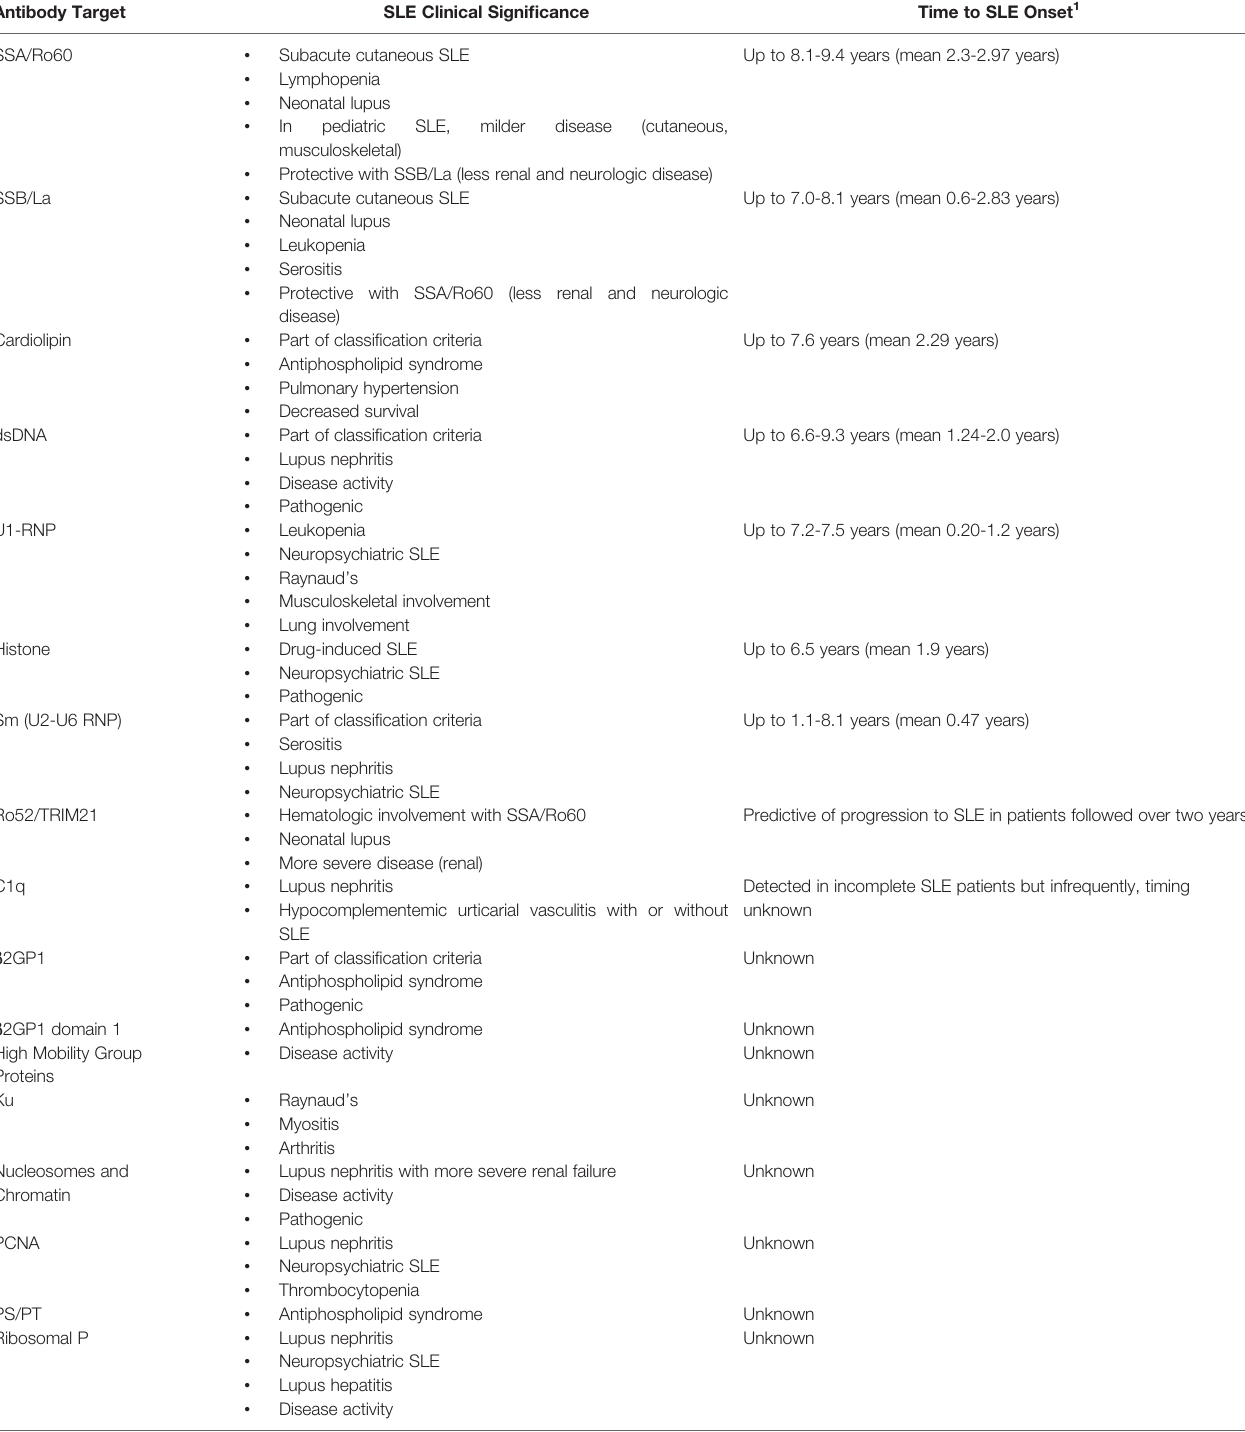
TABLE 1 | SLE autoantibodies, clinical signi fi cance, and time to SLE onset. Antibody Target SLE Clinical Signi fi